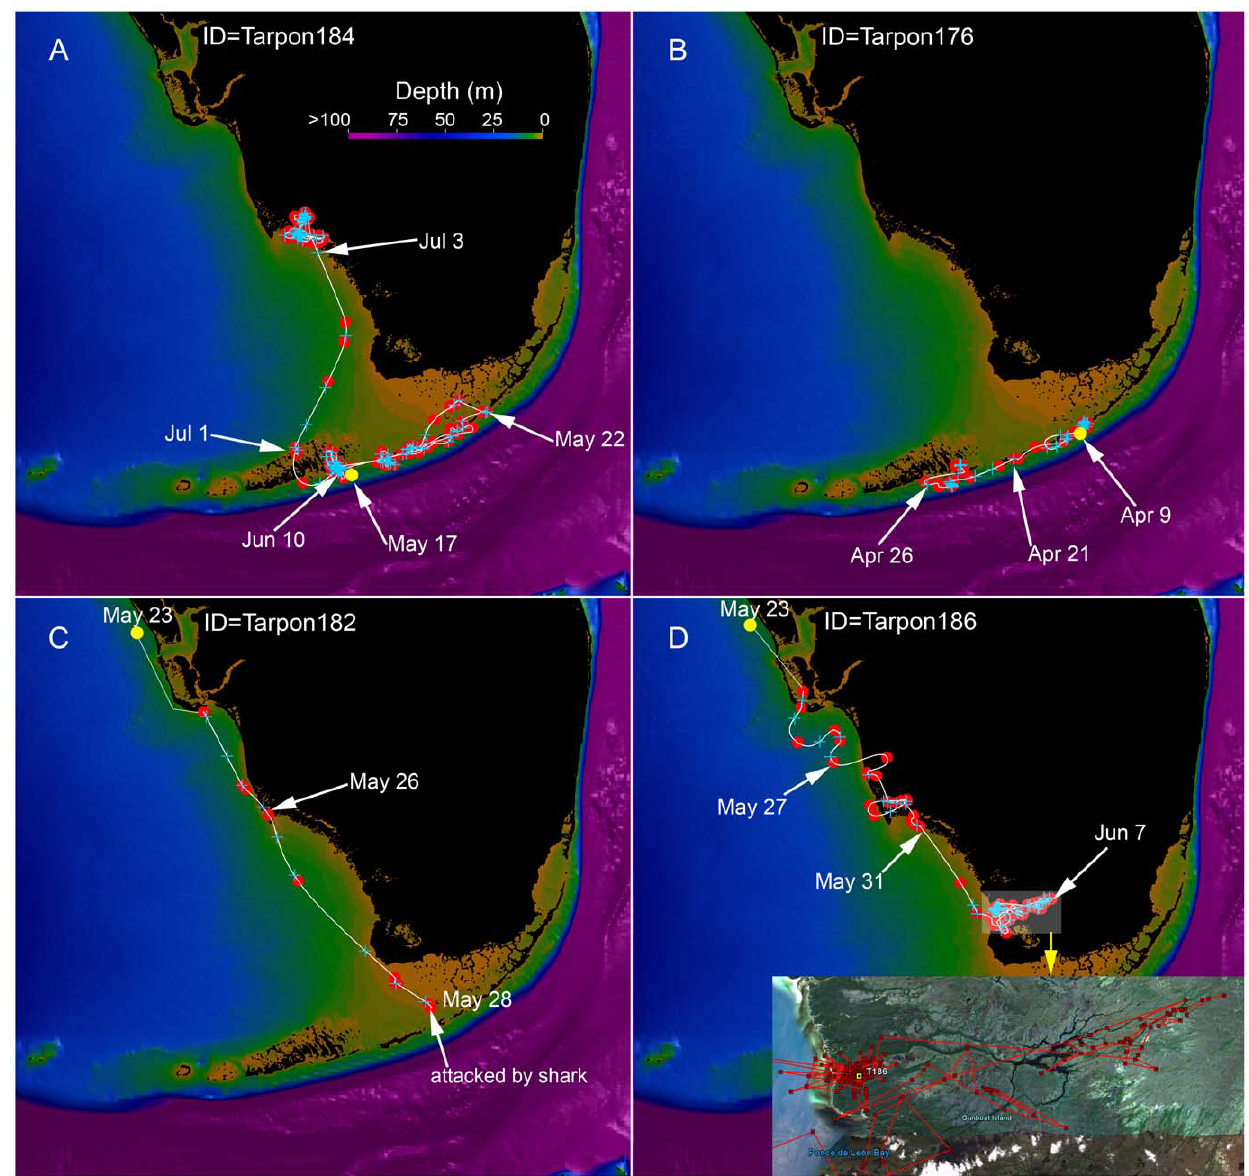
Figure 7. Representative example of four different tarpon tracks overlain on regional bathymetry. The red dots indicate the Argos locations, the white line is the 1-minute Bezier interpolated track, and the blue plus symbols are the 12-hour positions. The yellow dot is the tagging location. The depth is scaled from 0 to 100 m as indicated by the color bar. Major geographic locations are labeled in Fig. 1. doi:10.1371/journal.pone.0045958.g007 swimming at high ROM ( . 1 m/s), coinciding with areas where discussion for more details). Relatively few tarpon tracks, in shark kernel densities were high (kernel contours , 50%, i.e., relation to bull shark tracks, were distributed over open or deep ‘‘high-density’’ zones, Fig. 4, 8). This is statistically supported by waters (Fig. 4, 7). In contrast, tracks of tarpon, relative to bull the positive correlation from the regression model of tarpon ROM sharks, were clustered around shallow Keys and passes. Moreover, dependent on bull shark kernel density (Fig. 9 a). To inspect the tarpon tracks were also concentrated up rivers, where tracked bull data at different levels, two statistical analyses were conducted: (1) sharks were absent (Fig. 4, 7). Tarpon ROM were highest ( . 1 m/ with all tarpon data (black and red dots in Fig. 9 b) overlain on bull s) where bull shark kernel densities were highest ( , 50% kernel shark distribution; and, (2) with bottom 25% of ROM values (red contour) and ROM were slowest ( , 0.5 m/s) where shark kernel dots) for each 0.1 bin of bull shark kernel density. In these densities were lowest ( . 50% kernel contour, Fig. 4). Tagged analyses, bull shark kernel densities were rescaled from 0 to 1.0 for tarpon spent most of their time ( . 90%) swimming at relatively low low to high density and ROMs were transformed by log10. In ROM ( , 0.5 m/s, Fig. 4, 8), coinciding with areas where shark both analyses, correlations from the regressions were statistically kernel densities were lowest (kernel contours . 50%, i.e., ‘‘low- significant: for all data correlation coefficient (r) was 0.1035 density’’ zones). In contrast, tarpon spent little time ( , 4%)